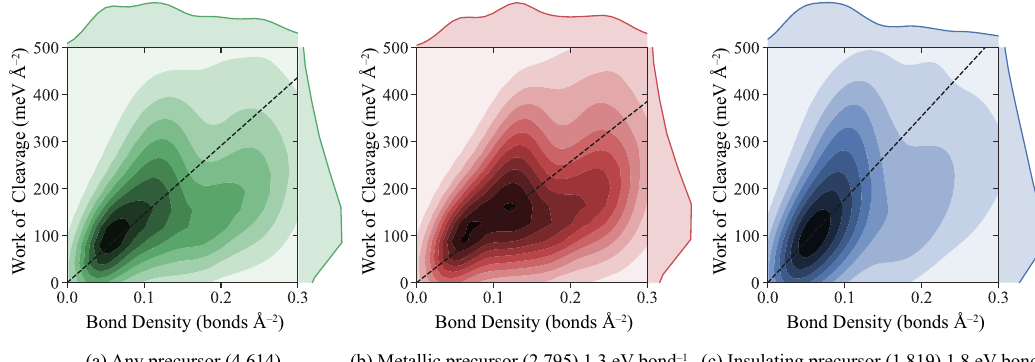
Fig. 4 Distribution of the work of cleavage vs. bond density of cleaved surfaces, with kernel density estimations. a represents all 4,614 cleavage surfaces, ( b ) for surfaces with metallic precursors, and ( c ) for surfaces with precursors exhibiting an electronic bandgap. We use the bandgap reported by Materials Project for the bulk precursors of the surfaces. The dashed lines indicate the mean energy per bond. On average, the metallic precursors exhibit a higher coordination number, and hence bond density for the cleavage plane in conjunction with a lower energy per bond than the more covalent and ionically bonded precursors. This trend is re fl ected in the average energy of the cleaved bonds for metals being lower at 1.3 eV bond − 1 compared to 1.8 eV bond − 1 for the cleaved covalent and ionic precursors.